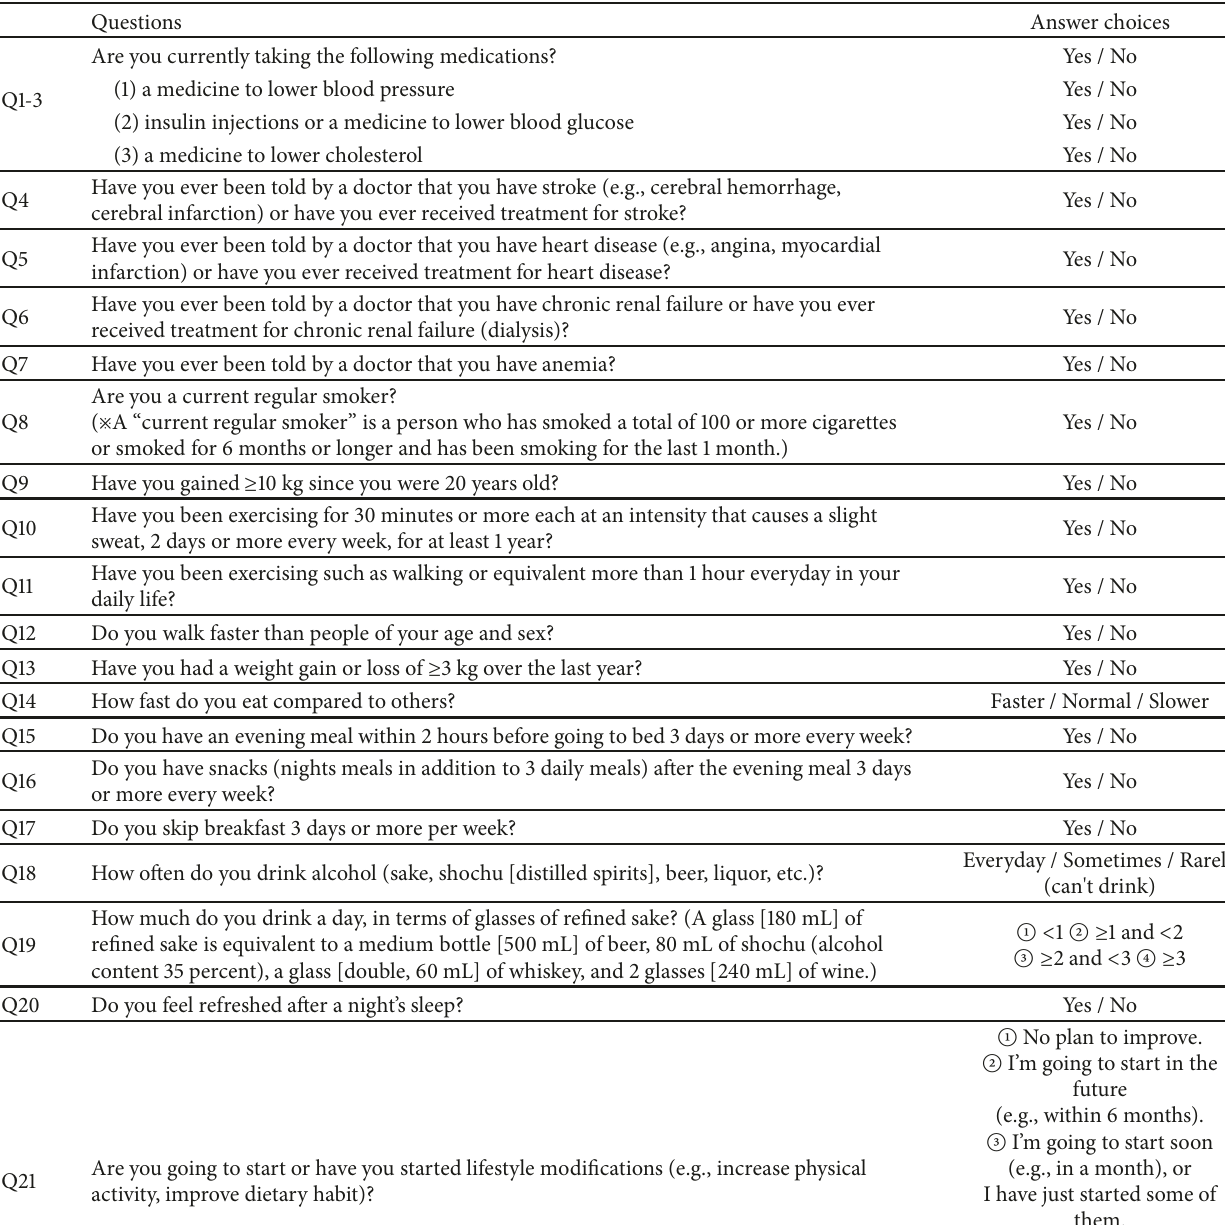
Table 7: The specific health checkups standard